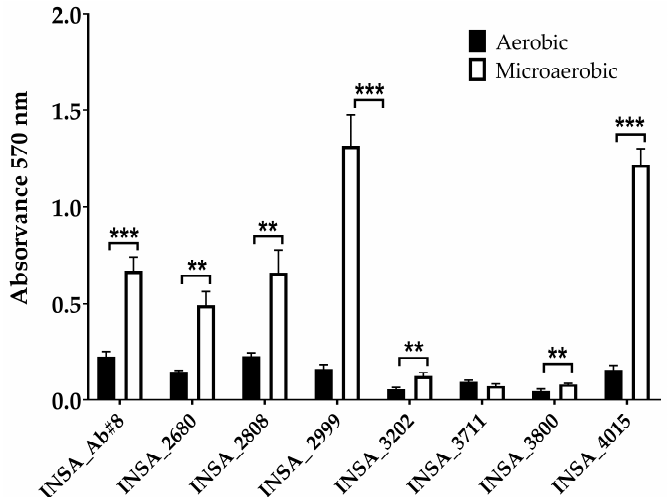
Figure 6. Biofilm formation ability by eight clinical isolates of Arcobacter butzleri evaluated by crystal violet staining when growth in aerobic and microaerobic conditions. Results were analysed using Student’s t -test. The data shown represent the mean ± standard deviation of at least three independent assays. ** p < 0.01, *** p < 0.001.